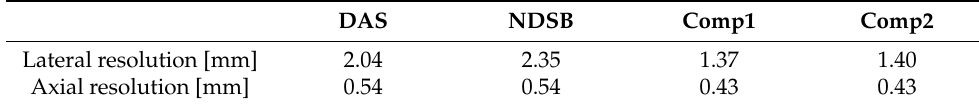
Figure 5. Lateral and axial profile of beamformed point target. ( a ) lateral profiles ( b ) axial profile. Table 1. Lateral and axial resolution for point target. Table 1. Lateral and axial resolution for point Table 1. Lateral and axial resolution for point target.